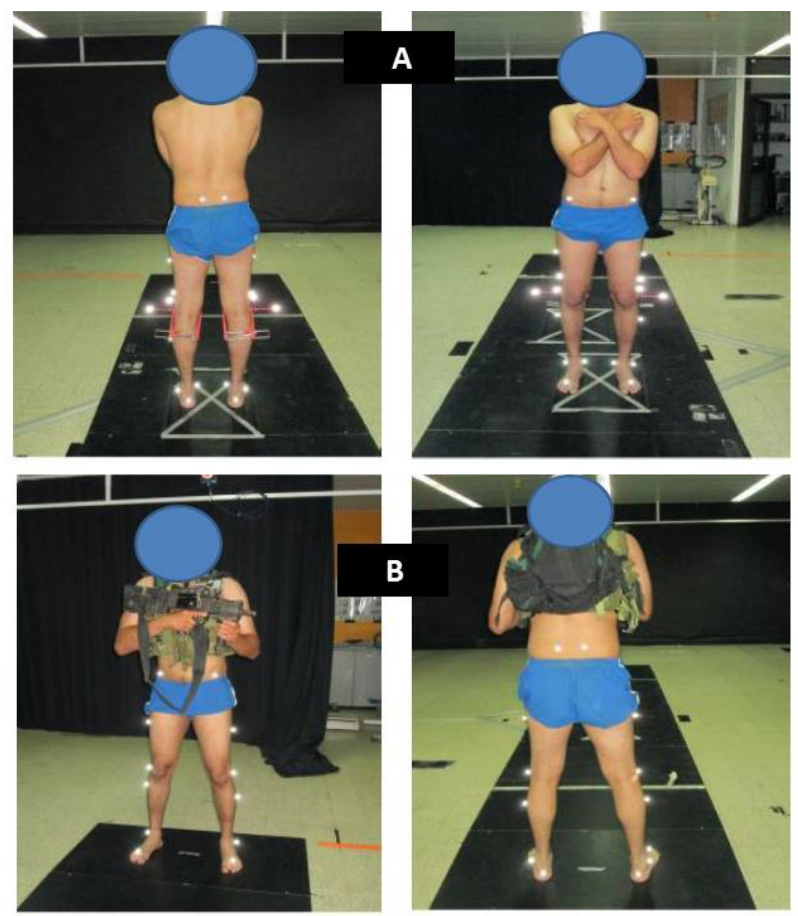
Figure 1. Markers on the subject’s body: ( A ) without load, ( B ) with load. The equipment included a rifle, battle vest and backpack. The weight in the pack was set so that the total additional weight of the gear was 50% of the soldier’s body mass [7,23]. All participants were weighed prior to the trial to ensure adequate weight and load. Practice walking trials were completed to allow for familiarization with the instru- ments and environment, including stepping on the force plates without changes in walking velocity. Subsequently, three successful trials were performed for each condition (with or without load). A successful trial was considered when the participant walked through